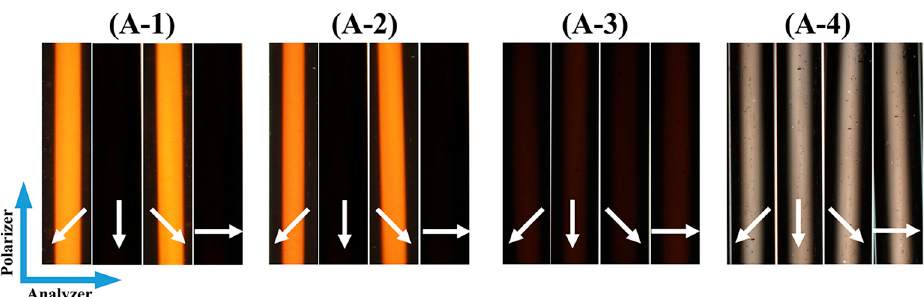
Figure 11. ( A ) Magnetic-field-direction-dependent polarized optical microscope (POM) of the aligned system showing uniform extinction and passage of light; ( A-1 ) the angle between the polarizer and the magnetic field direction was 0°; ( A-2 ) 45°; ( A-3 ) 90°; ( A-4 ) 135°. ( B-1 – B-4 ) POM images of samples: ( B-1 ) without a magnetic field, ( B-2 ) with a magnetic field, ( B-3 ) after removal of the magnetic field, ( B-4 ) with a magnetic field again.